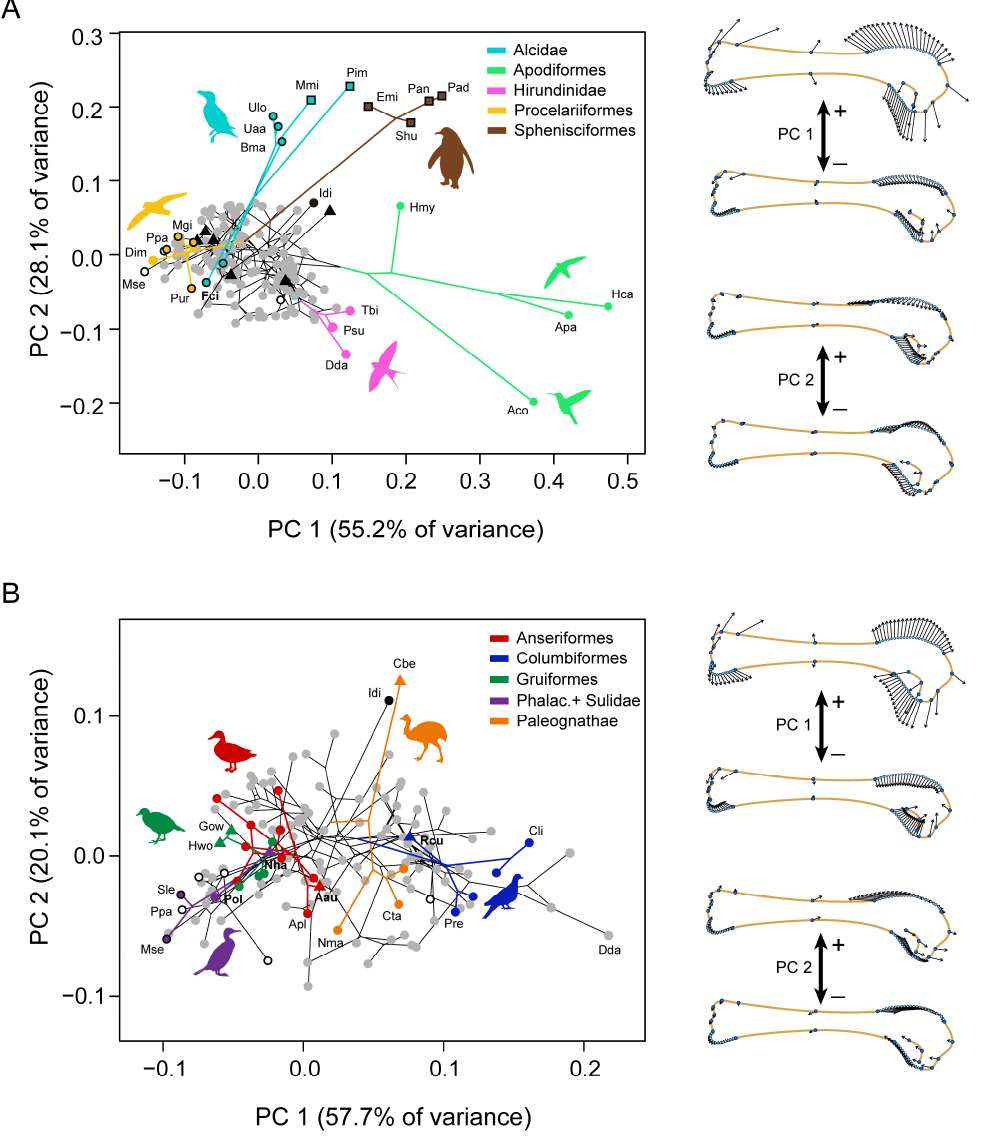
Figure 6. Allometric-free variation of humeral shape. ( A ) Phylomorphospace depicting the two first principal components of the PCA and vector graphs showing the shape changes associated with each of the axes. ( B ) Phylomorphospace depicted by the two first principal components of the PCA on the subsample excluding Apodiformes, Sphenisciformes and Alcidae, and vector graphs showing the shape changes. Symbols’ shape corresponds with the function of wings given in Figure 2. Abbreviations: Aau, Anas aucklandica ; Aco, Archilochus colubris ; Apa, Apus pacificus ; Apl, Anas platyrhynchos ; Bma, Brachyramphus marmoratus ; Cbe, Casuarius bennetti ; Cli, Columba livia ; Cta, Crypturellus tataupa ; Dda, Delichon dasypus ; Dim, Diomedea inmutabilis ; Emi, Eudyptula minor ; Fci, Fratercula cirrhata ; Gow, Gallirallus owstoni ; Hca, Hirundapus caudacutus ; Hmy, Hemiprocne mystacea ; Hwo, Hypotaenidya woodfordi ; Idi, Ichthyornis dispar ; Mmi, Mancalla milleri ; Mgi, Macronectes giganteus ; Mse, Morus serrator ; Nha, Nannopterum harrisi ; Nma, Nothura maculosa ; Pad, Pygoscelis adeliae ; Pan,